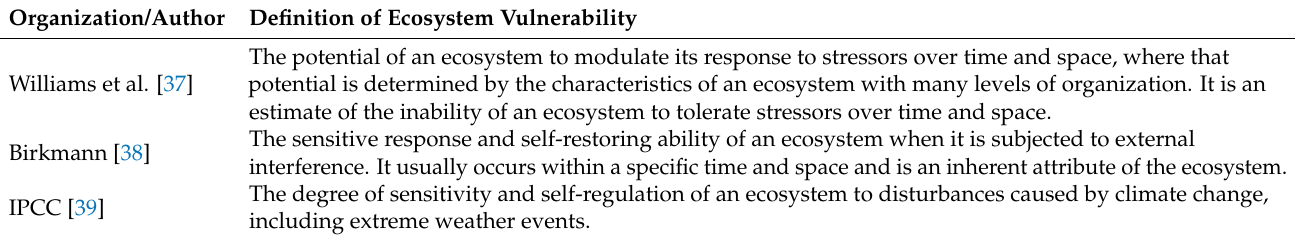
Table 1. Some definitions of ecosystem